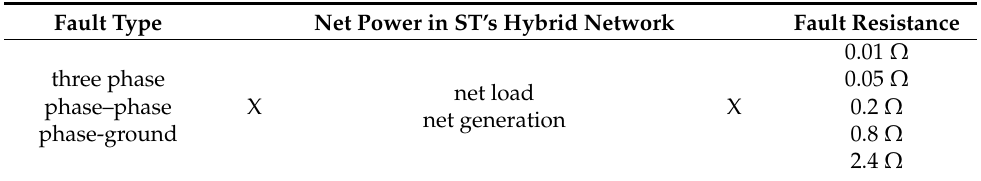
Table 1. Operational scenarios.